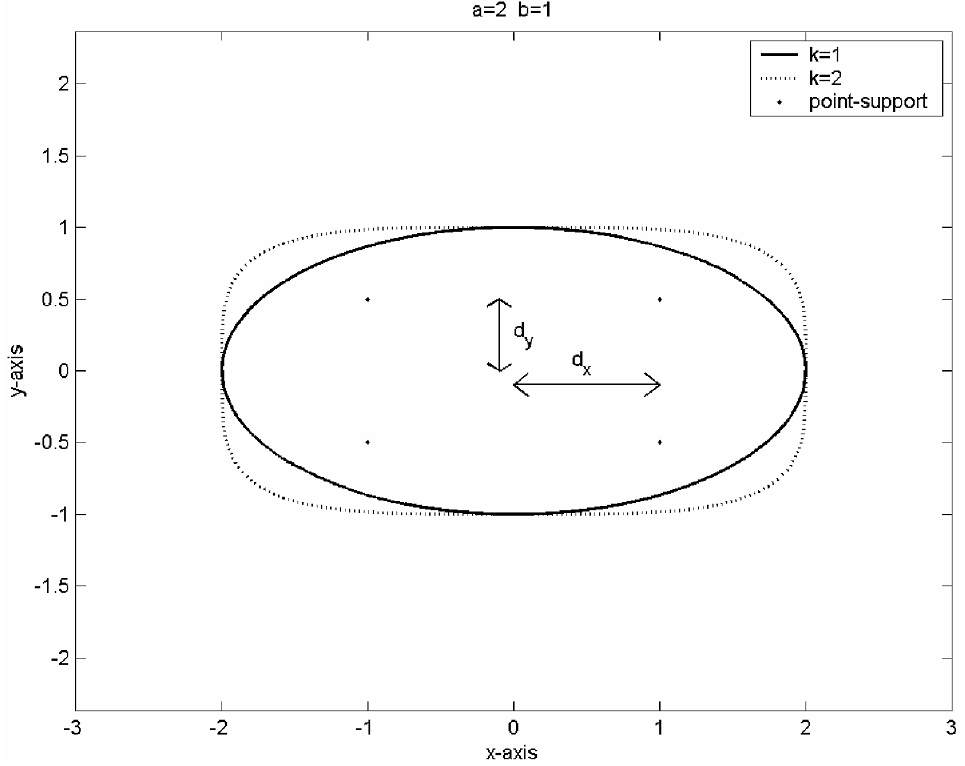
Fig. 1. Geometry of the